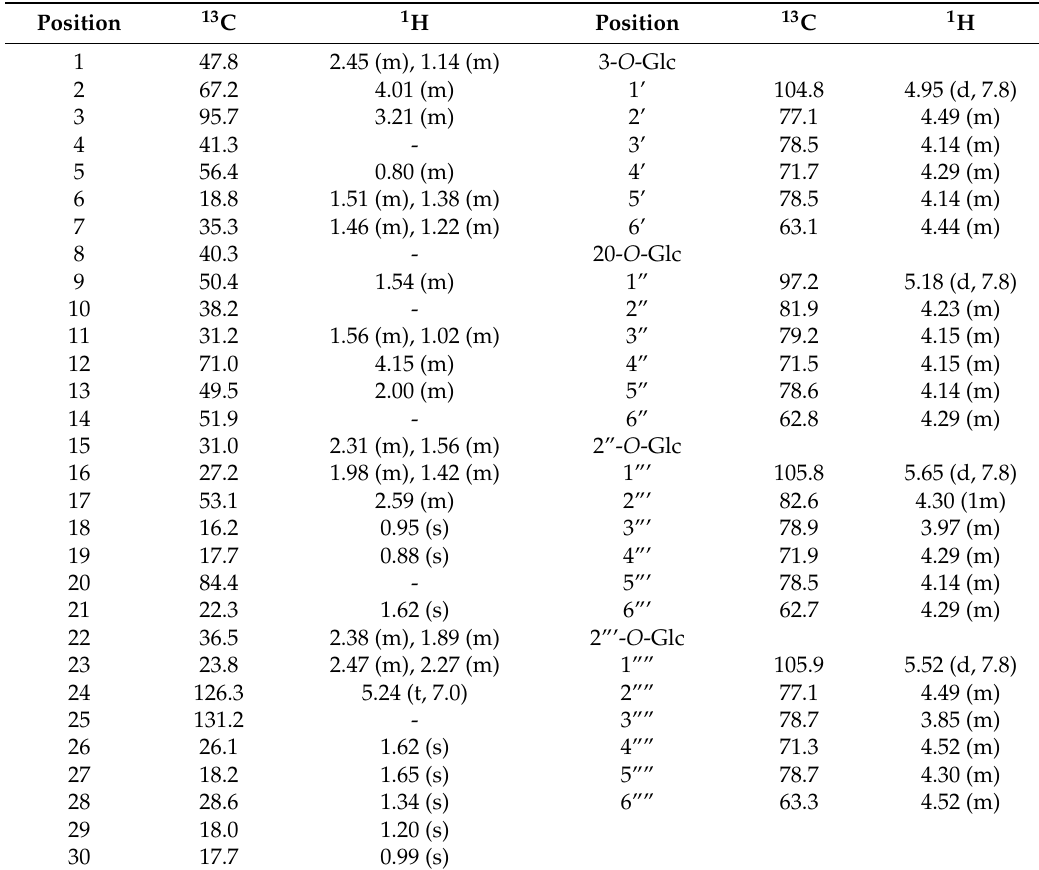
Table 5. 1 H-NMR and 13 C-NMR spectral data of compound 10 (600 MHz and 150 MHz, pyridine- d 5 , δ in ppm, J in